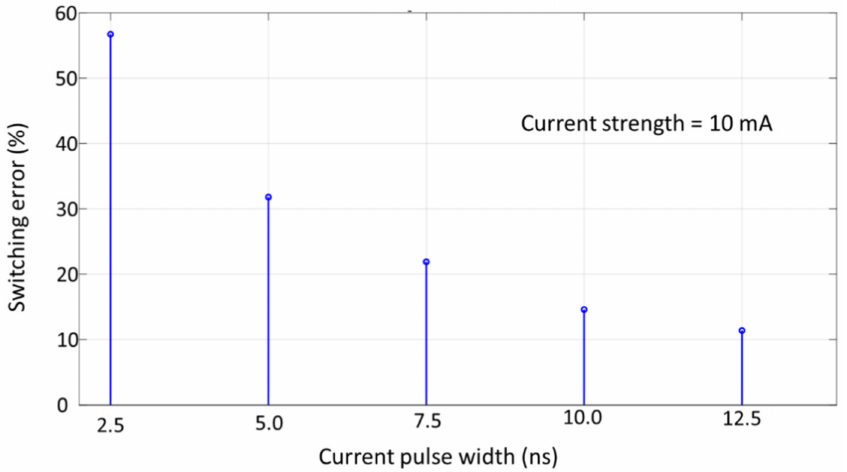
Figure 4. Switching error probability as a function of current pulse width (i.e., the duration of spin–transfer–torque). The current strength was kept fixed at 10